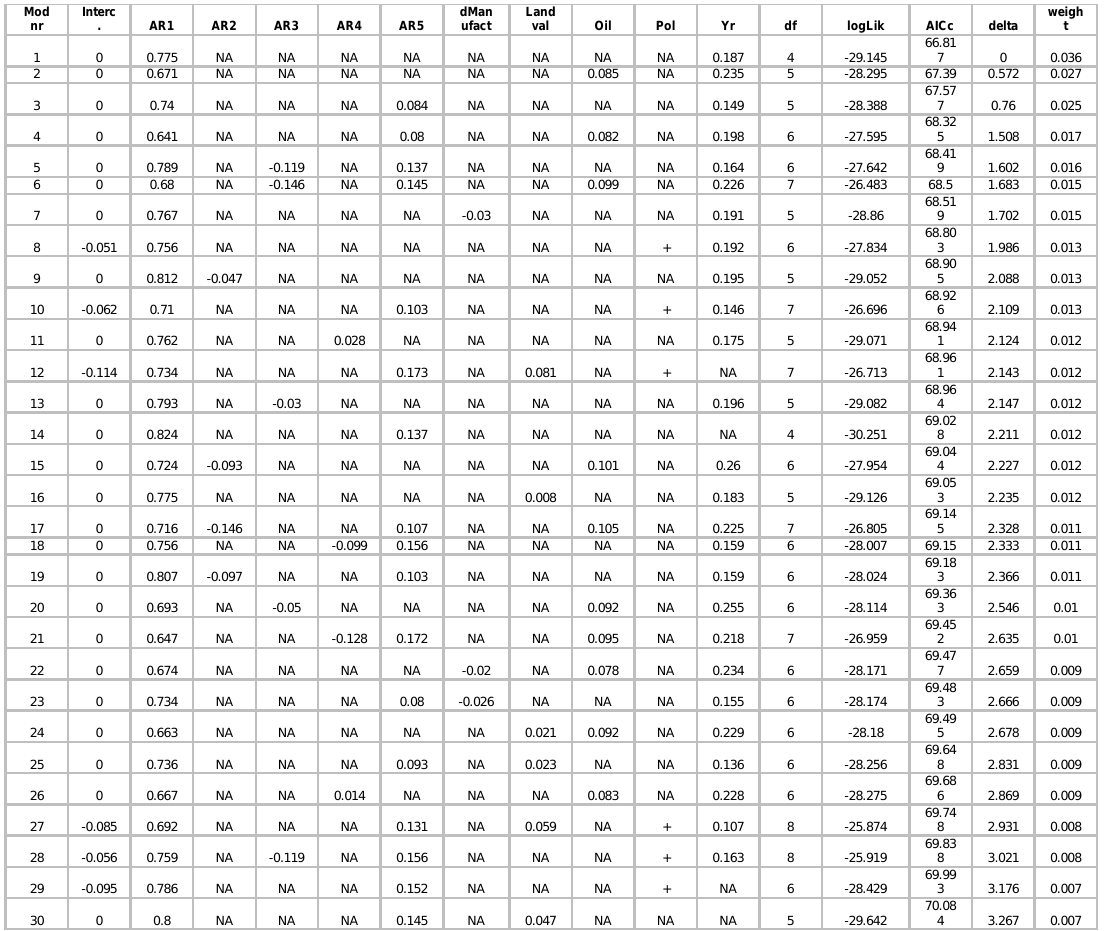
Table A1.4. Model selection table for statistical models explaining total subsidy levels for 1914-1994. Average parameter values calculated from weighting all models are given in Table A1.6. Only first 30 models